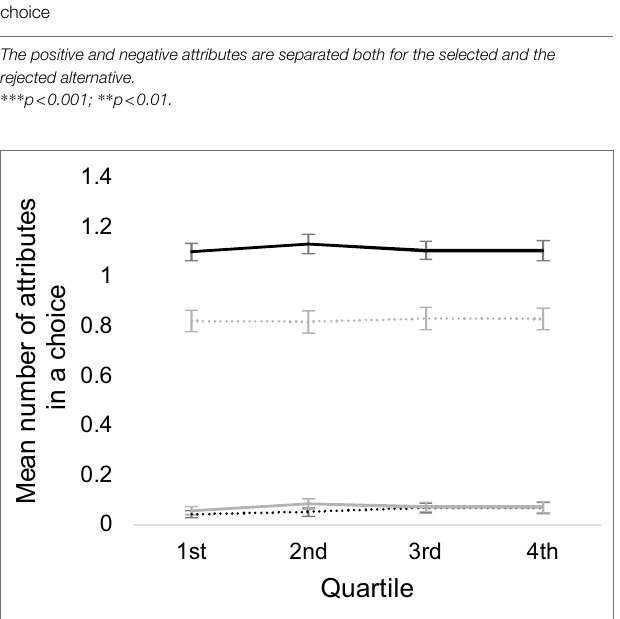
FIGURE 4 | Mean number of attributes in all choices, divided into quartiles according to the decision times. The x -axis represents the different quartiles of decision times. Black lines represent the number of chosen alternatives, gray lines the number of rejected alternatives, and solid lines and dashed lines the positive and negative attributes,